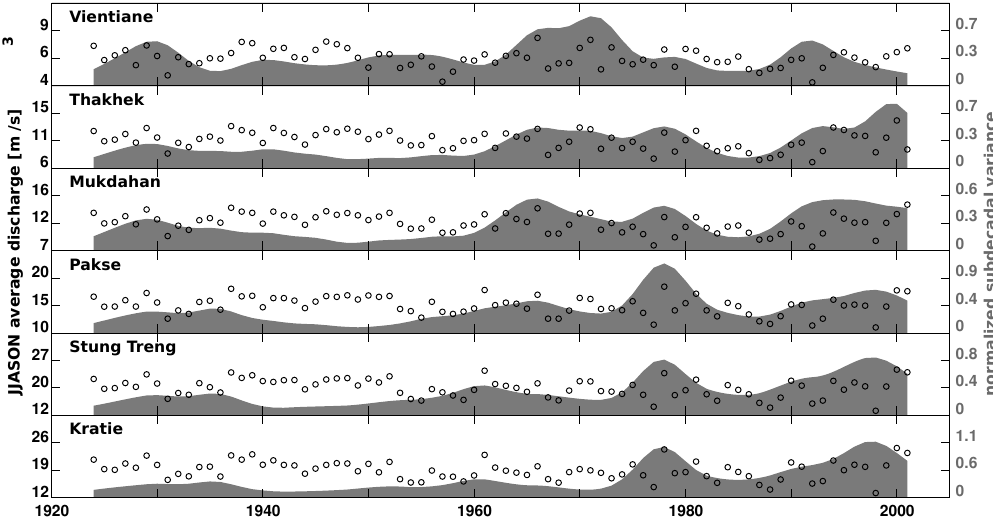
Fig. 2. Dots represent JJASON (June to November) discharge averages (left axis). The shaded areas show the subdecadal variability of the transformed discharge estimated with the Morlet wavelet (right axis). Lower stations show a later enhancement in